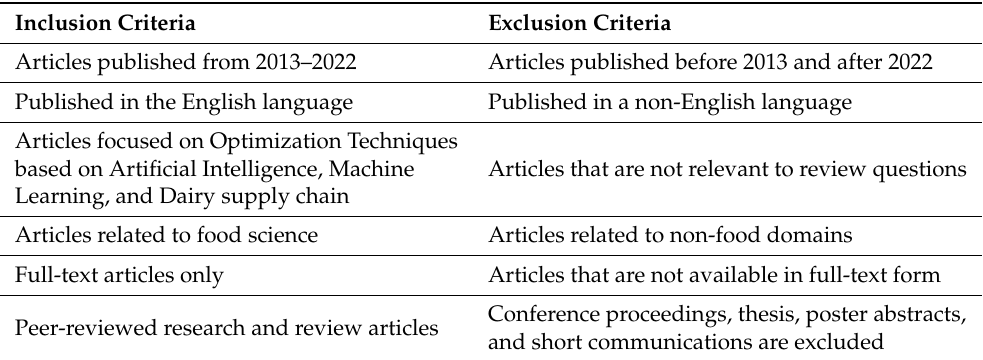
Table 1. Inclusion/exclusion